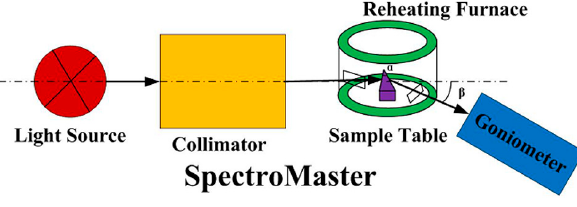
Figure 3. The experimental setup of measurement.